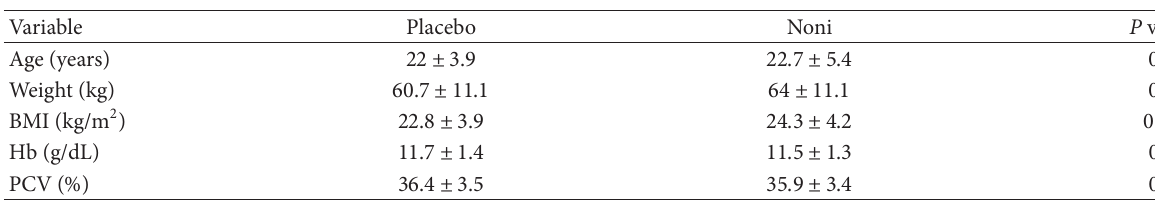
T 1: Characteristics and values of subjects at